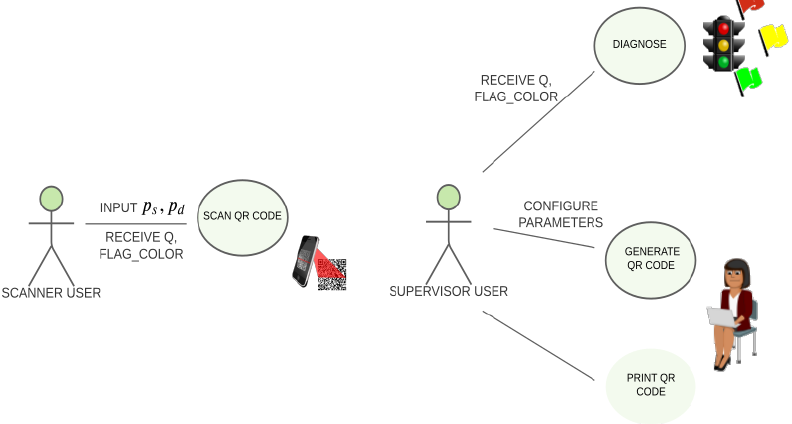
Figure 3. Use case diagram for the software